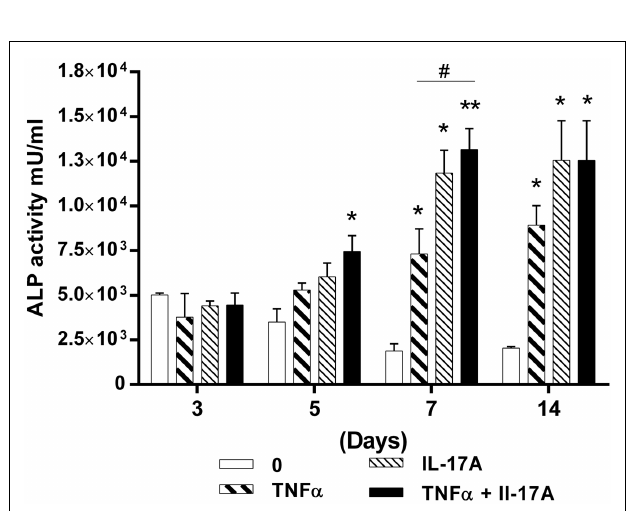
FIGURE 1 | Effects of IL-17A and/orTNF- α on extracellular matrix mineralization are shown . hMSCs were plated at a density 5 × 10 3 cell/cm 2 and cultured for 21days (A) in the absence (column 1) or presence (column 2) of osteogenic factors, 1ng/mlTNF- α (column 3) or 50ng/ml IL-17A (column 4),